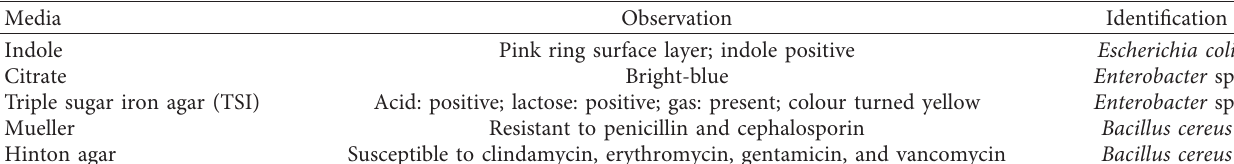
Table 3: Identification of microbial contaminants.